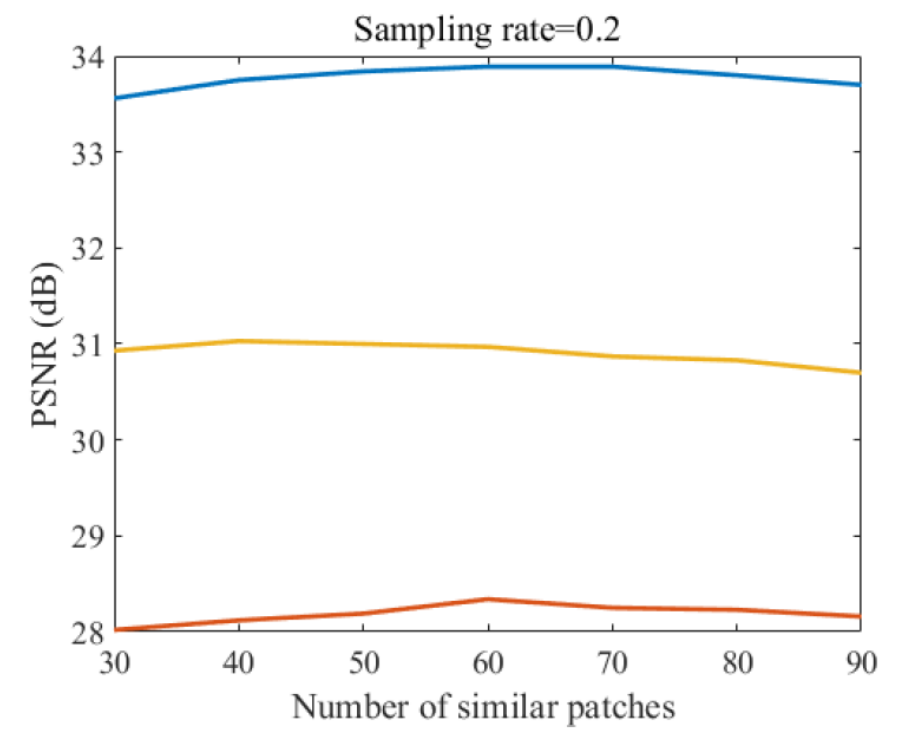
Figure 10. Performance comparison with different number of patches for three test images in case of sampling rate = 0.2.